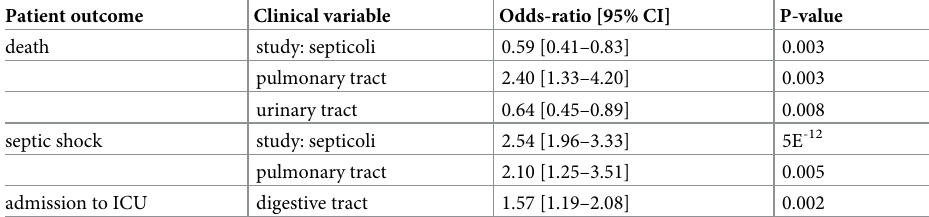
Table 2. Multivariate analysis on the combined dataset. Clinical variables with p-value < 0.01 are reported for each patient outcome; the intercept is excluded. CI, confidence